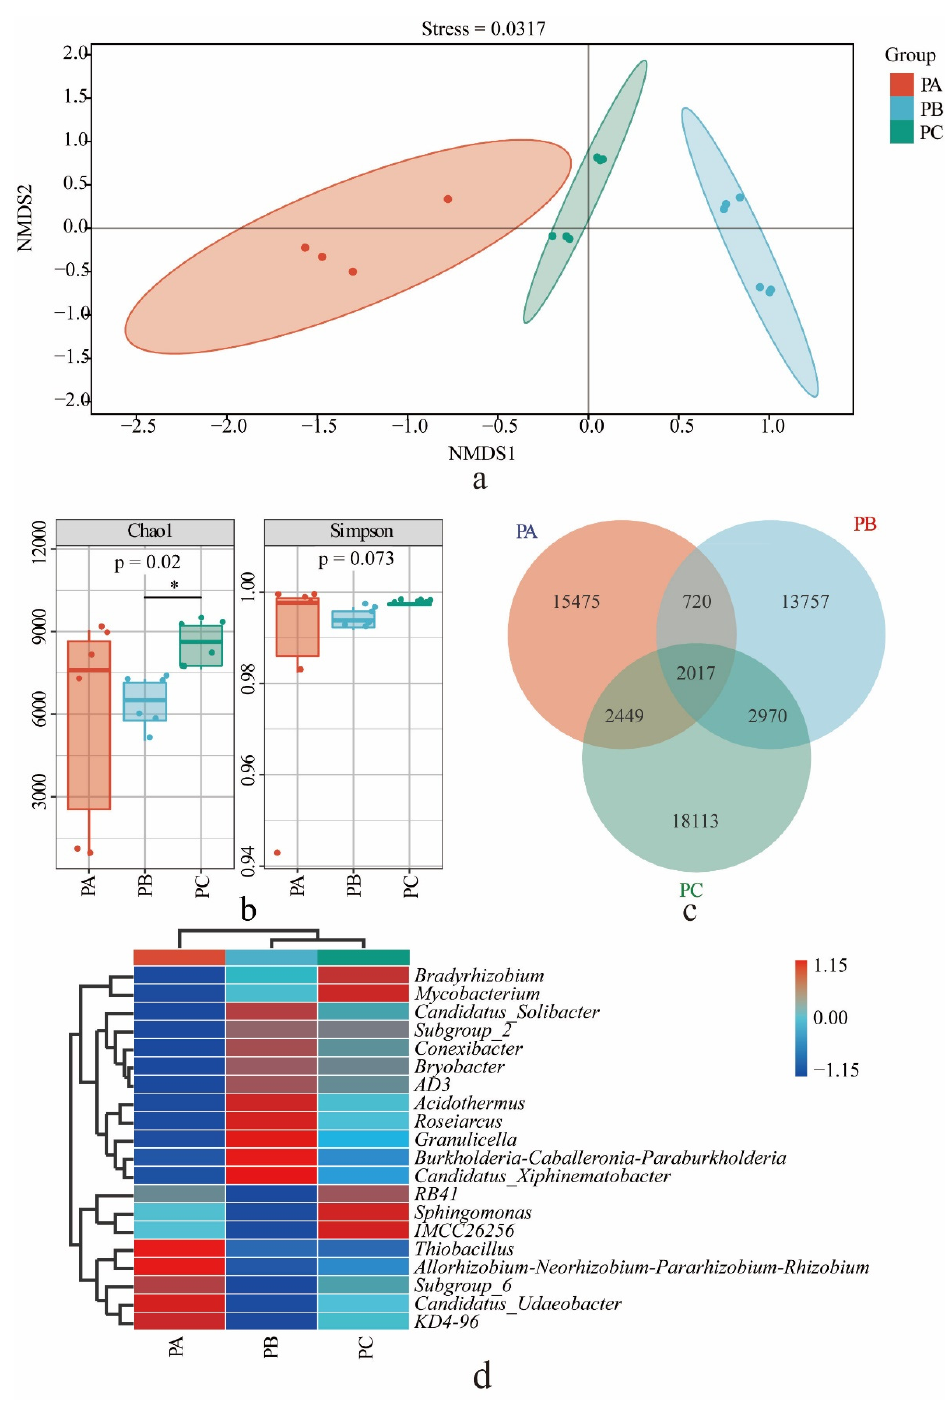
Figure 1. Bacterial community in the soil from three collection sites: ( a ) NMDS analysis of bacterial β -diversity from three collective sites, ( b ) alpha diversity of bacteria, the asterisk (*) represents a significant difference at p < 0.05 level, ( c ) Venn map of bacteria, ( d ) a heat map of the bacteria composition of the first 20 genera. PA, soil sample from plot A; PB, soil sample from plot B; PC, soil sample from plot